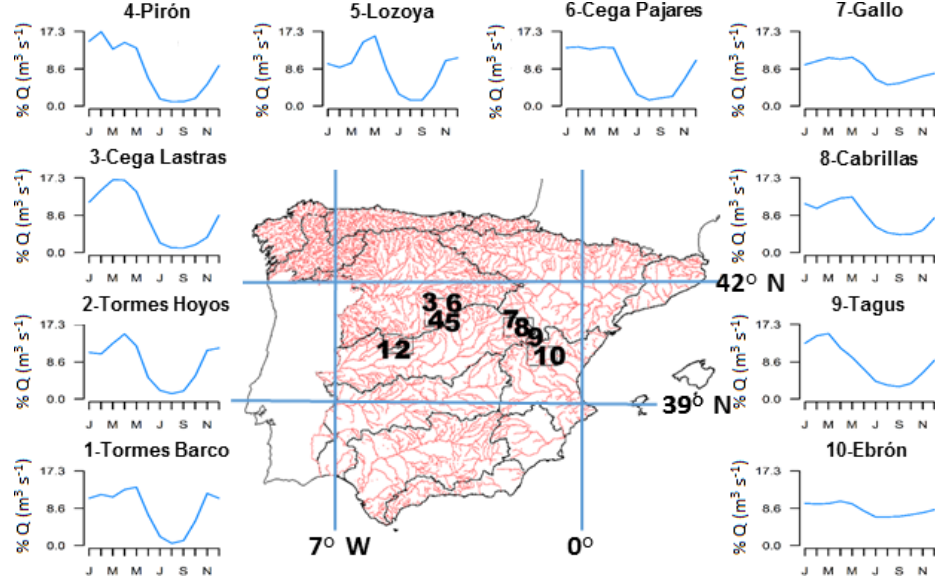
Figure 3. River regime patterns for the different gauging stations. The flows are expressed as percentages of the mean annual flow, and the months (horizontal axis) are ordered from January to